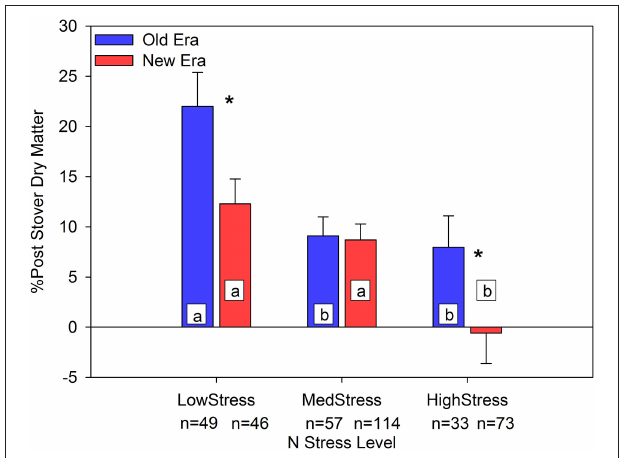
FIGURE 4 | Relationship between N stress level, as determined by NNI at R1, and the percent change in stover dry matter from R1 to R6 (%PostStover DM) across maize genotypes in the Old and New Eras. Different letters signify LSMeans within Eras (Old or New) are significantly different across N stress levels. An *denotes a significant difference between the Old and New Era LSMeans within a given N stress level. *denotes significance at the 0.05 probability level.